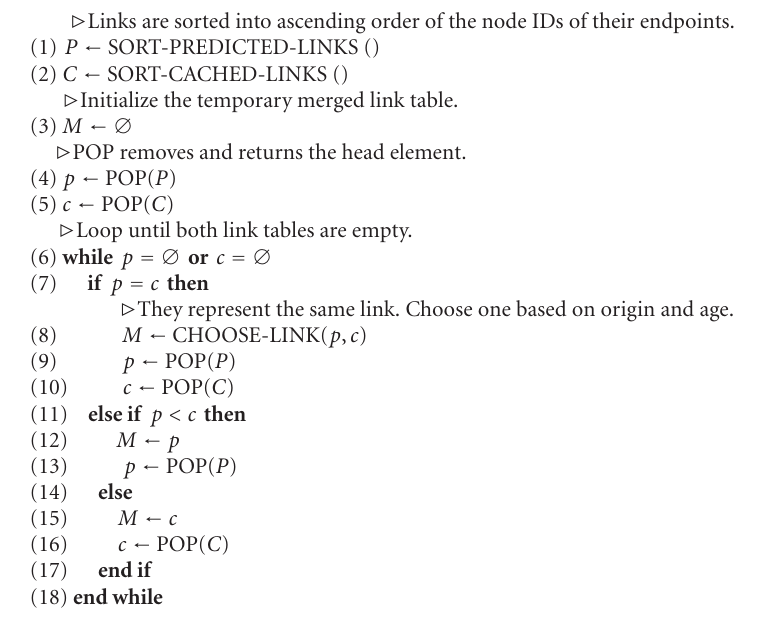
Algorithm 3: A simplified version of the algorithm used to merge the link data from the link cache and the tracking system. At the conclusion of the merge, M contains the merged link table.